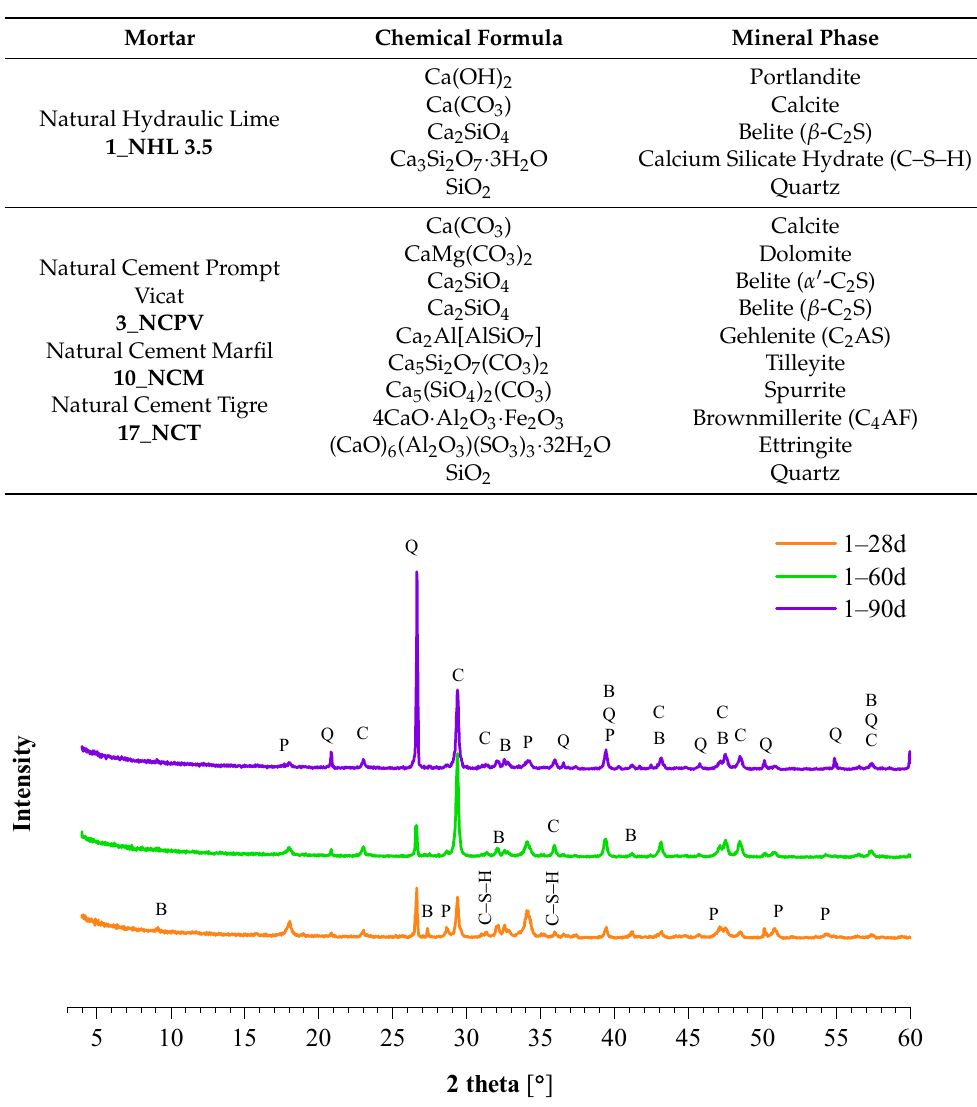
Table 5. Mineralogical composition of mortars identified by XRD analysis.